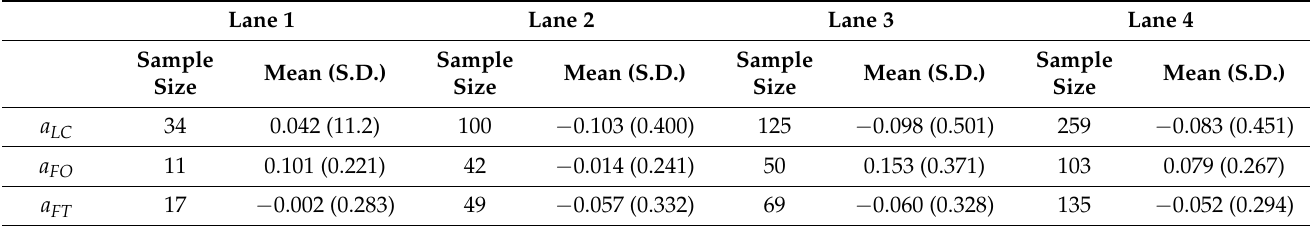
Table 1. Speed change of vehicles on different travel